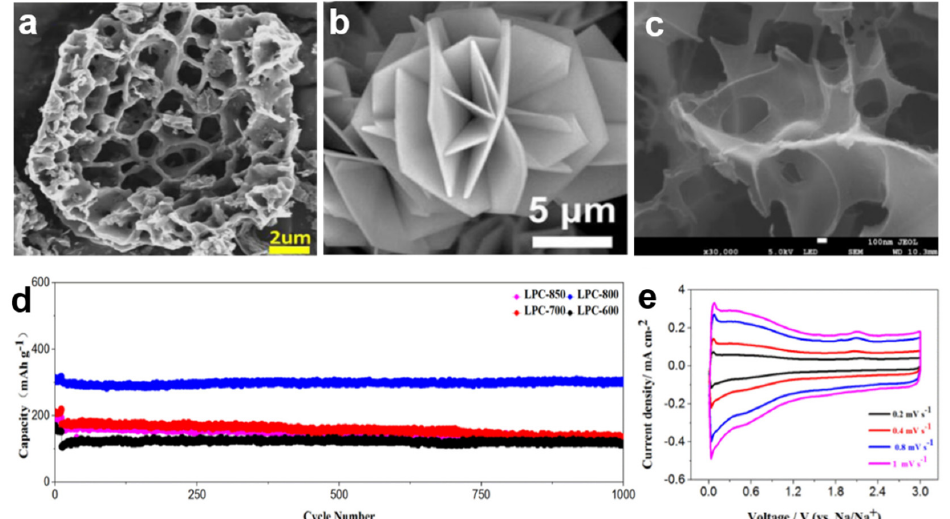
Figure 5. ( a ) SEM images of “honeycomb” structure carbon. ( b ) SEM images of CoP/C. Reprinted with permission from Ref. [89]. Copyright 2018 American Chemical Society. ( c ) SEM images of porous carbons from longan shells. ( d ) Cycling stability performance of different samples at a current density of 5 A g − 1 . ( e ) CV curves of porous carbons. Reprinted with permission from Ref. [88]. Copyright 2018 Elsevier.